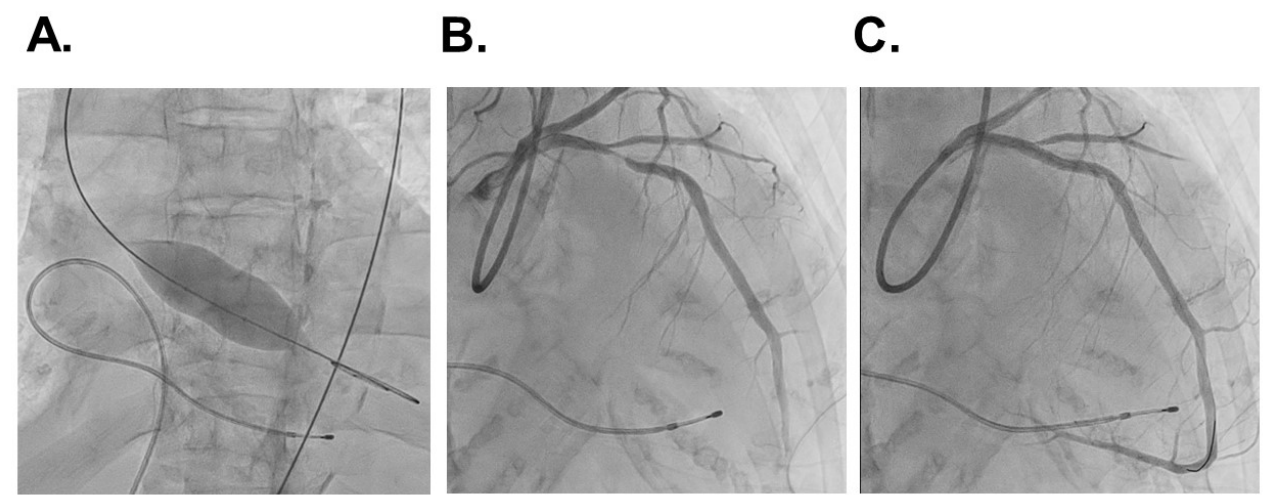
Figure 4. Balloon aortic valvuloplasty ( A ) and coronary angiography exhibiting significant stenosis at the mid left anterior descending artery ( B ) and those after successful percutaneous coronary intervention using drug-eluting stent ( C ).